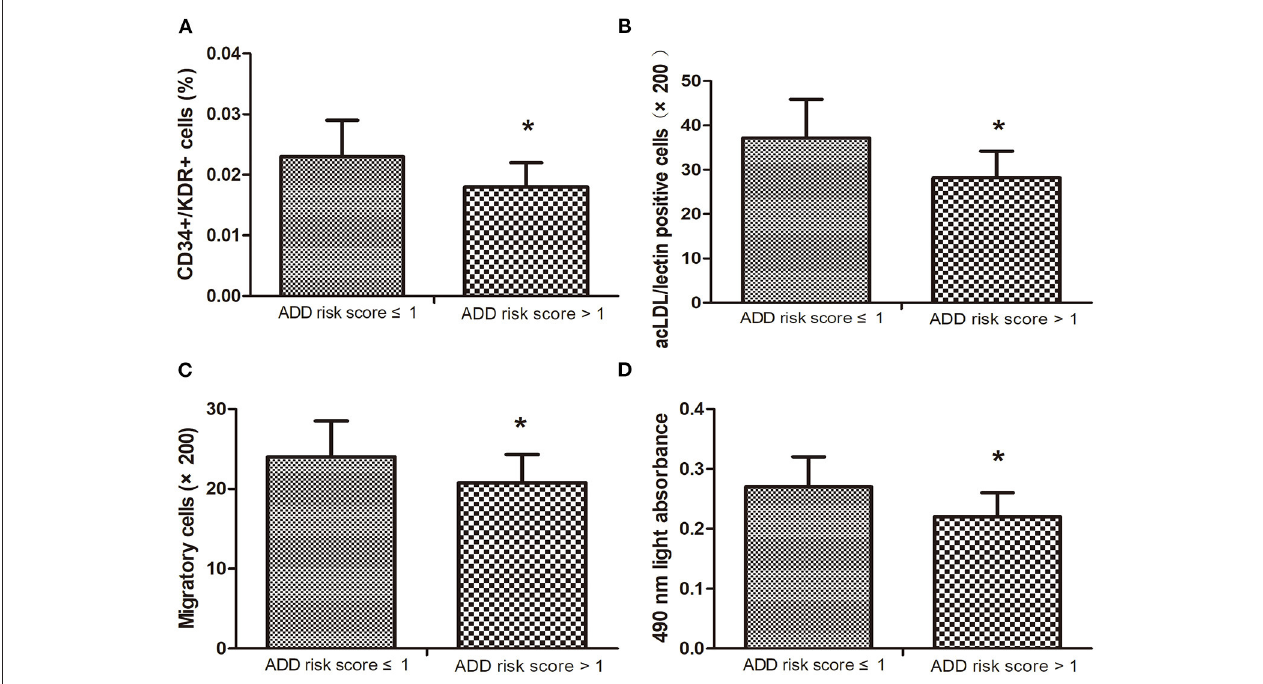
FIGURE 2 | The number of circulating endothelial progenitor cells (EPCs) (A,B) in high ADD-RS group were lower than that in low ADD-RS group. The migratory (C) and proliferative (D) activities in low ADD-RS group were higher than that in high ADD-RS group. Data are given as the means ± standard deviation (SD). * p < 0 05 vs. ADD risk score ≤ 1